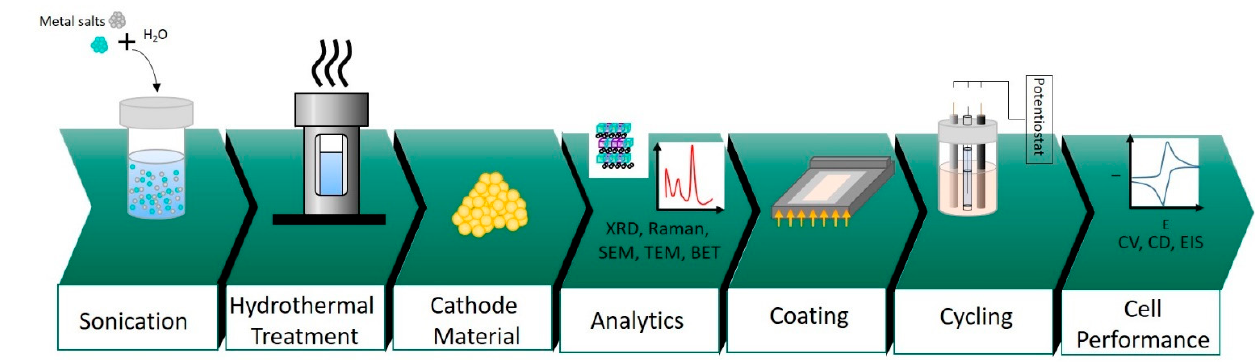
Figure 1. Schematic illustration of the various process steps from synthesis to characterization.